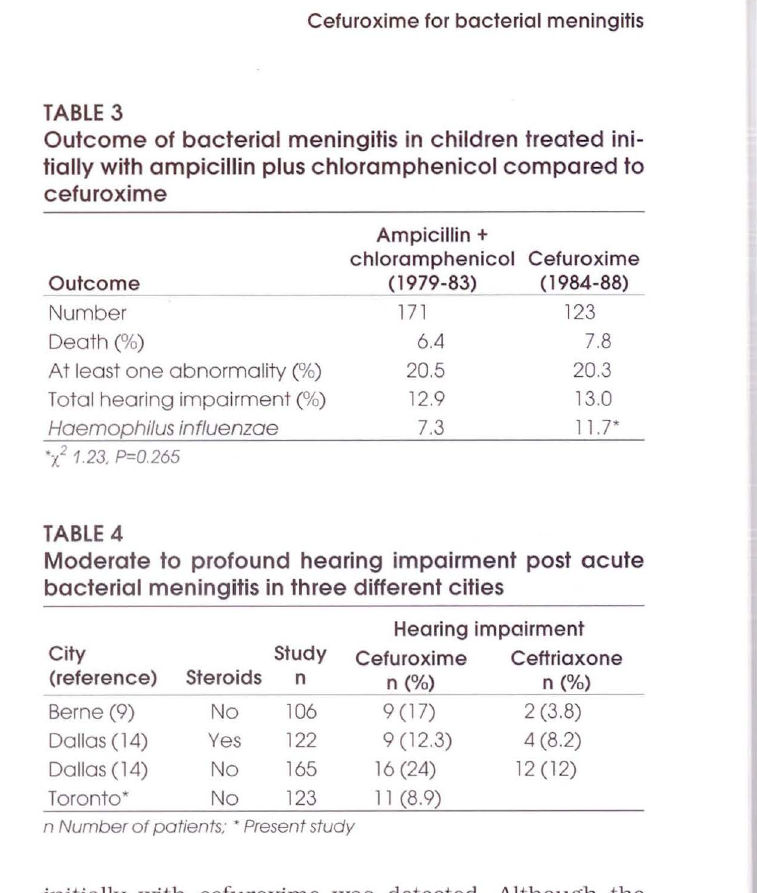
Outcome of bacterial meningitis in children treated ini tially with ampicillin plus chloramphenicol compared